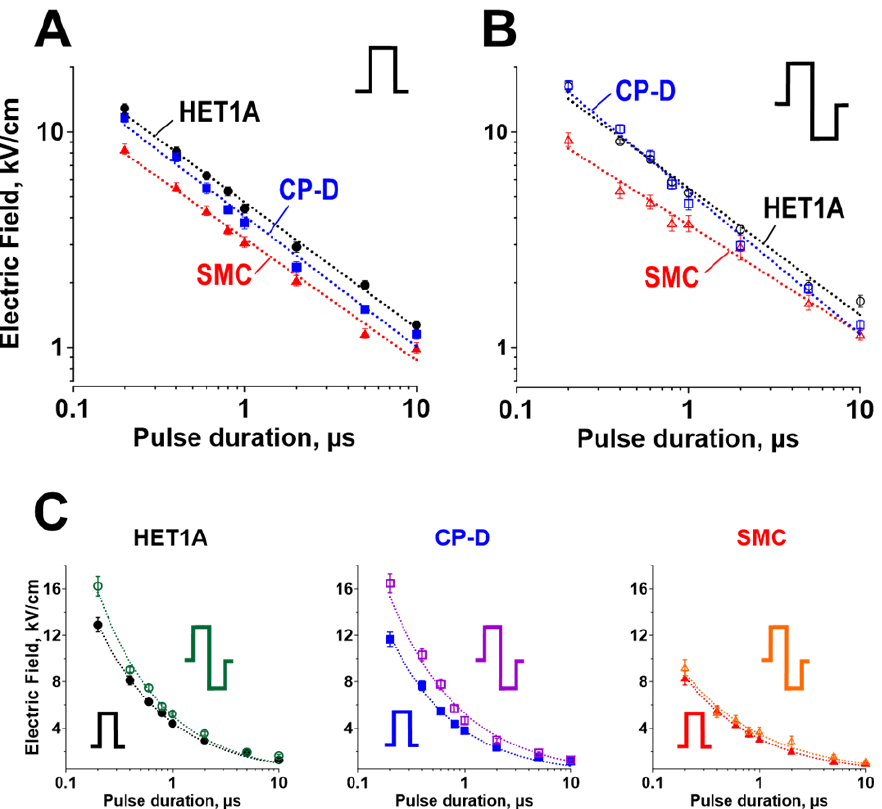
Figure 1. LD50 electric field strength for normal epithelial (HET1A), pre-malignant epithelial (CP-D), and smooth muscle cells (SMC) as a function of pulse duration for a 10 Hz, 100-pulse train. ( A , B ) display LD50 for uni- and bipolar pulses, respectively. ( C ) compares LD50 for uni- and bipolar pulses (filled and open symbols) in each individual cell type. For bipolar pulses in ( B , C ), the duration of one phase was used instead of the total pulse duration. Note a double-log scale in ( A , B ), but a semi-log scale in ( C ). For each individual data point, LD50 was determined by Hill equation fitting of cell death data from 5 to 14 independent experiments (see Section 4.4). Error bars (95% confidence intervals of the Hill fit at 50% survival) may not be visible if they are smaller than the central symbol. Dotted lines are the best fits of LD50 values using a power